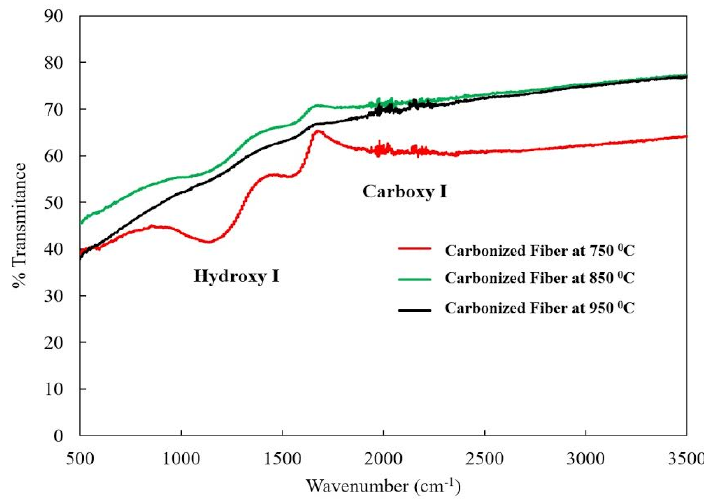
Figure 3. The Fourier transform infrared spectroscopy (FTIR) spectrum of carbonized (PAN) fibers at 750, 850 and 950 °C.